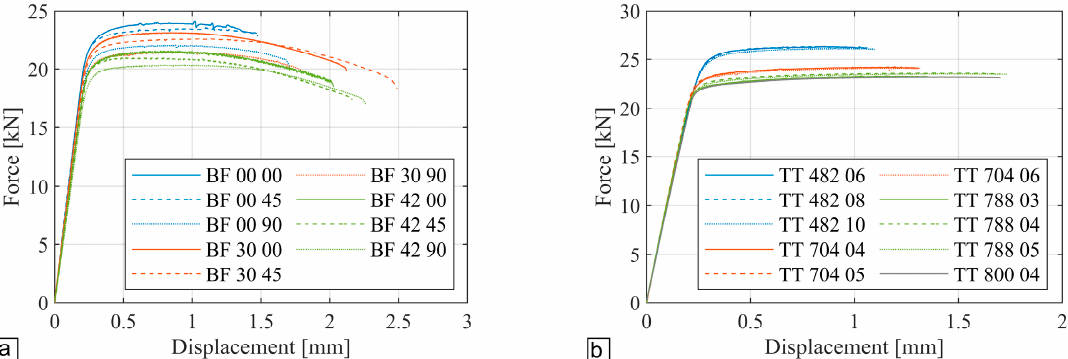
Figure 9. Force–displacement curves for ( a ) the barrel-finished samples and ( b ) the heat-treated samples.